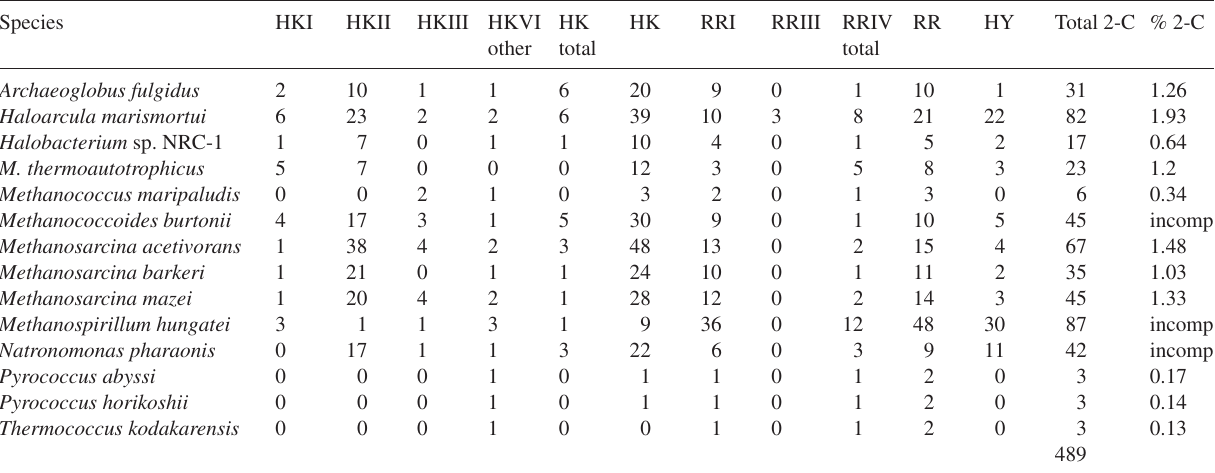
Table 3. Distribution of euryarchaeal two-component open reading frames. The total number of identified two-component genes are shown (Total 2-C) and are given as a percentage of the total protein coding capacity of each genome (% 2-C). Abbreviations: HK = histidine kinase; RR = re- sponse regulator; HY = hybrid kinase; and incomp =